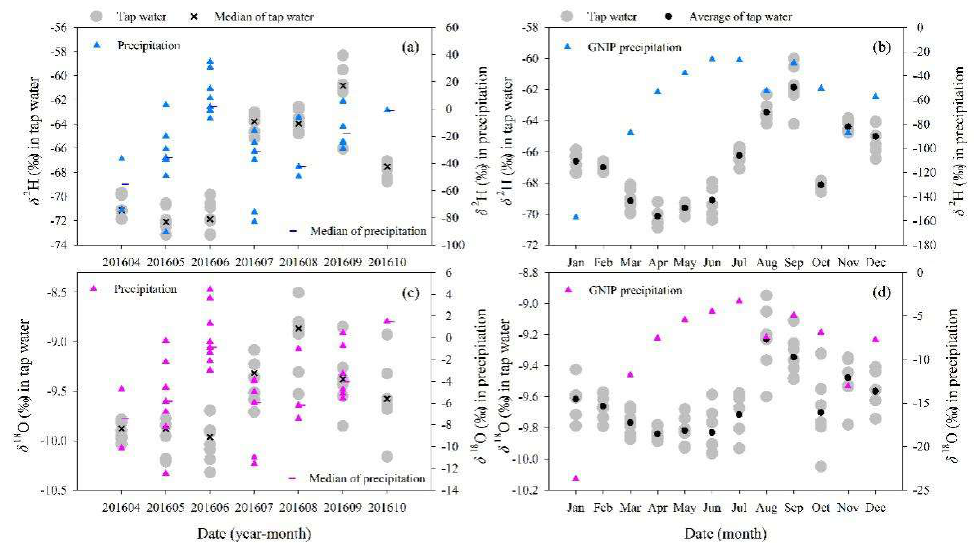
Figure 8. Comparison of temporal variations of δ 2 H and δ 18 O in tap water with those in collected precipitation ( a , c ) and those in precipitation from GNIP [48] (Global Network of Isotopes in Precipitation) ( b , d ). ( a , c ) The data of δ 2 H and δ 18 O in collected precipitation at the site of Qiujiawan (P-1) are from April 2016 to October 2016. The monthly data of δ 2 H and δ 18 O in tap water at 7 sampling sites are from April 2016 to October 2016. ( b , d ) The monthly mean values of δ 2 H and δ 18 O in GNIP precipitation at the site of Lanzhou are from 1985 to 1999 (the monthly mean values of δ 2 H and δ 18 O in February are absent). The monthly data of δ 2 H and δ 18 O in tap water at 7 sampling sites are between March 2016 and February 2018.